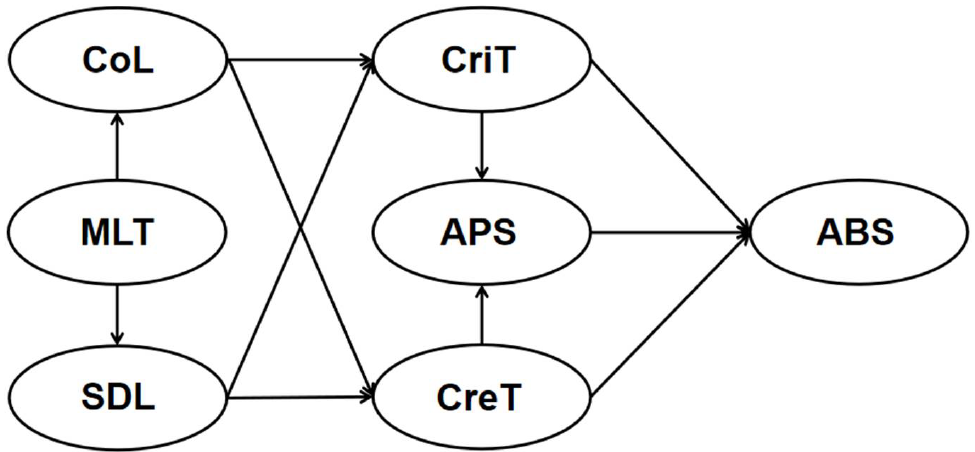
Figure 1. The hypothesized model for medical students’ 21st century online learning patterns.